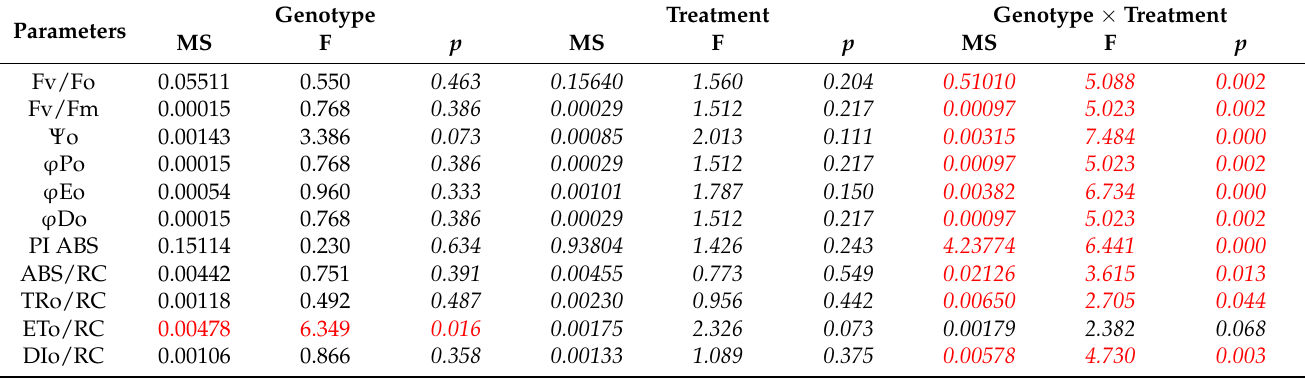
Table 6. Results of two-way ANOVA for two barley genotypes (Golden Promise and Haruna Nijo) grown under salt stress (150 mM sodium chloride) after bikinin treatment (non-treated; treated with 0.11% DMSO; and treated with 10 µ M, 50 µ M, and 100 µ M bikinin dissolved in 0.11% DMSO) were calculated for photosystem II efficiency, measured in the 3rd leaf (Fv/Fo, PSII potential ac- tivity; Fv/Fm, PSII maximum photochemical efficiency; Ψ o, probability (at t = 0) that a trapped excitation moves an electron into the electron transport chain beyond QA; ϕ Po, maximum quantum yield of primary photochemistry (at t = 0); ϕ Eo, quantum yield of electron transport (at t = 0); ϕ Do, quantum yield (at t = 0) of energy dissipation; PI ABS, performance index (potential) for energy conservation from an exciton to the reduction of intersystem electron acceptors; ABS/RC, absorption flux (of antenna Chls) per RC; TRo/RC, trapping flux (leading to QA reduction) per RC;